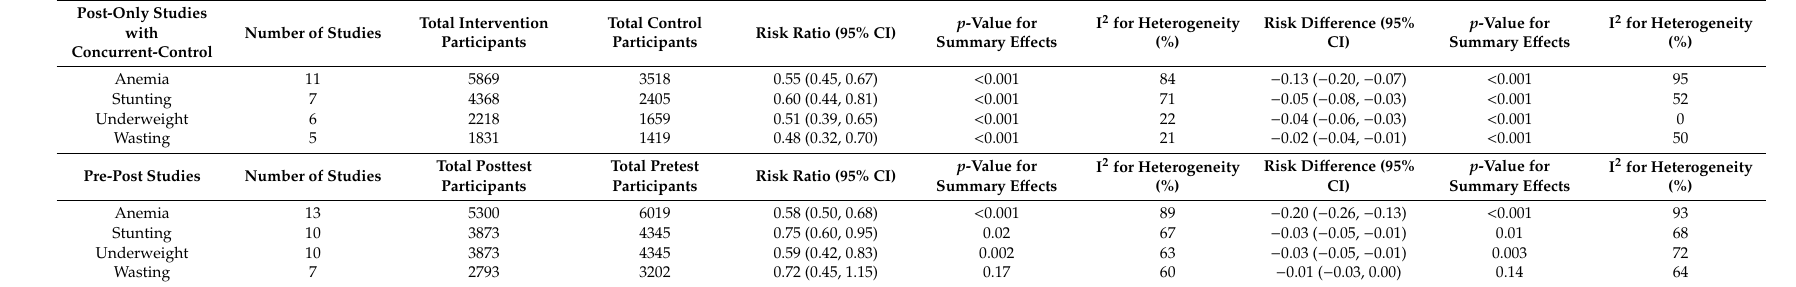
Table 4. The e ff ect of YYB on prevalence of child anemia and the categorical outcomes of nutritional status in